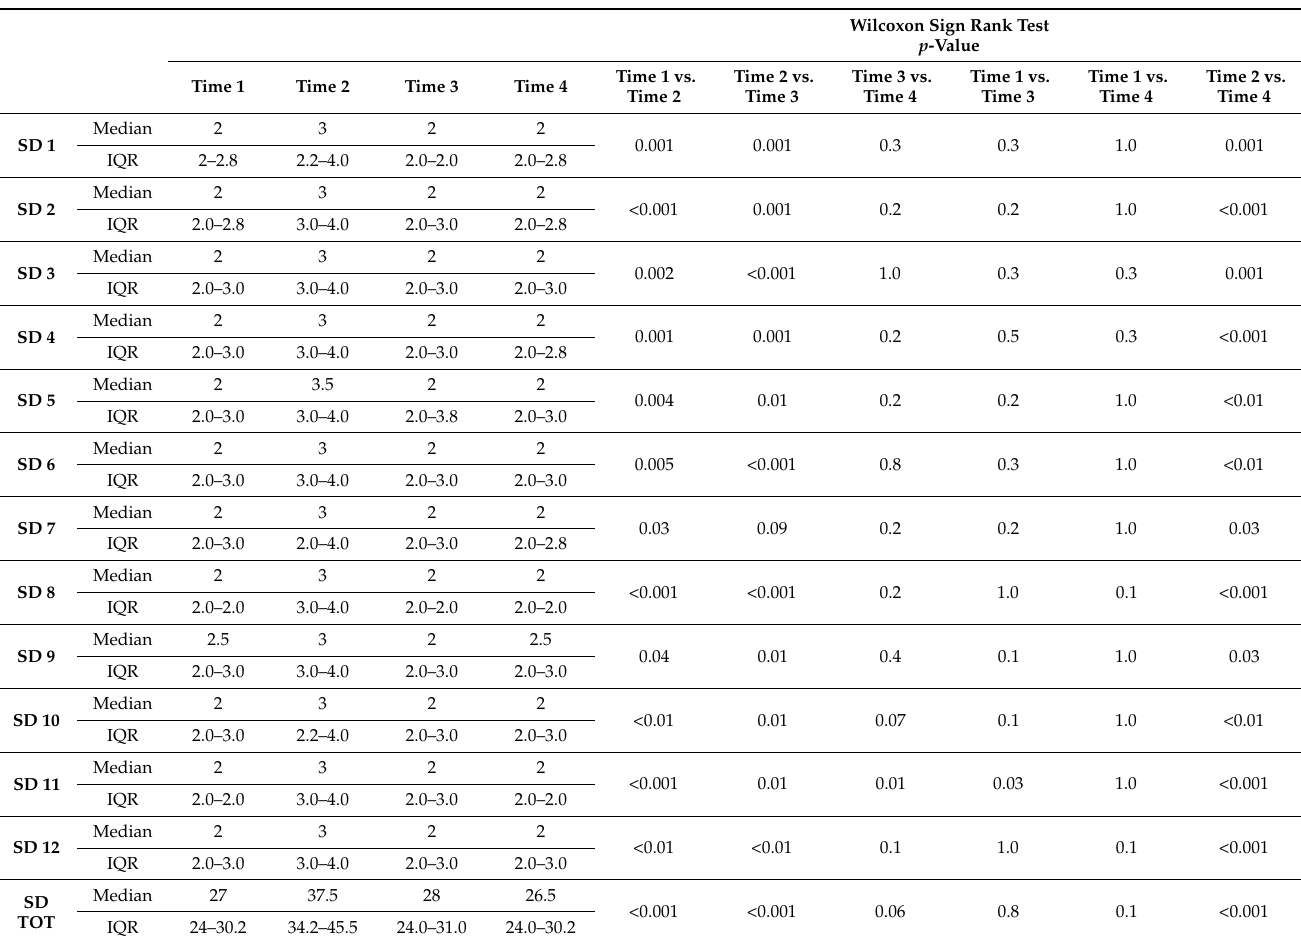
Table 4. Sexual distress schedule administrated to 22 COVID-19 patients in the periods before being tested (Time 1), during quarantine (Time 2), 1 month after a negative test (Time 3), and 3 months after a negative test (Time